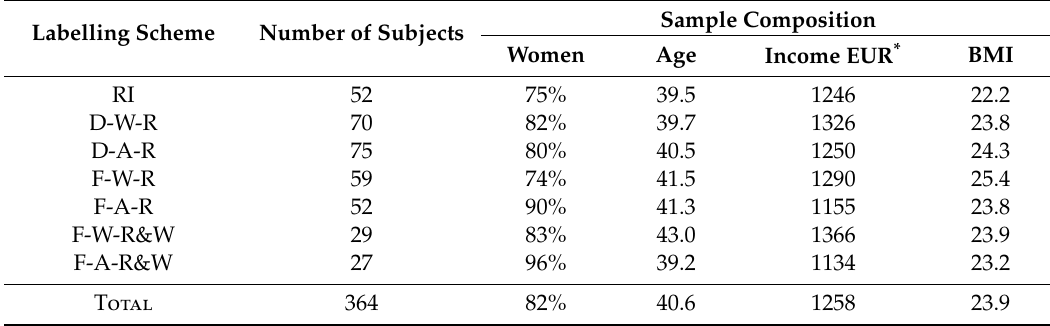
Table A2. Description of the experimental sample per labelling system (Number of subjects; frequency of women; mean age; mean income per consumption unit per household; mean BMI).